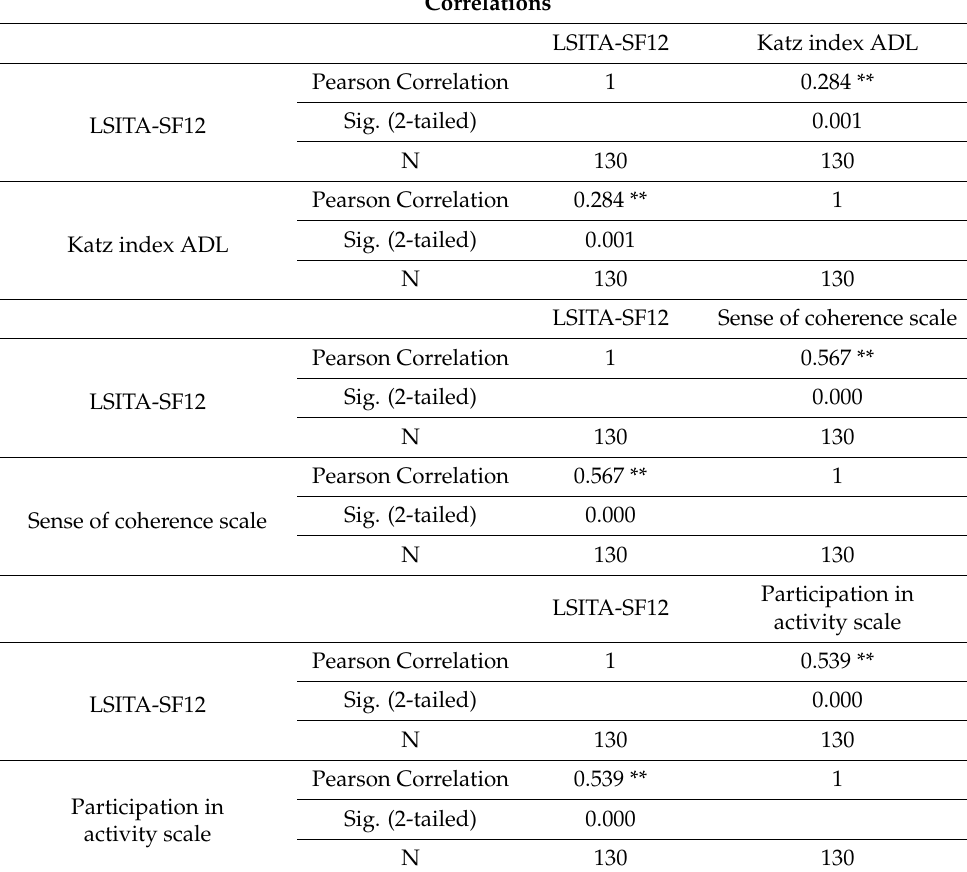
Table 4. The correlation between 12 items Life Satisfaction Index for the Third Age—Short Form (LSITA-SF12) and Katz index ADL, sense of coherence scale, participation in activities scale, and